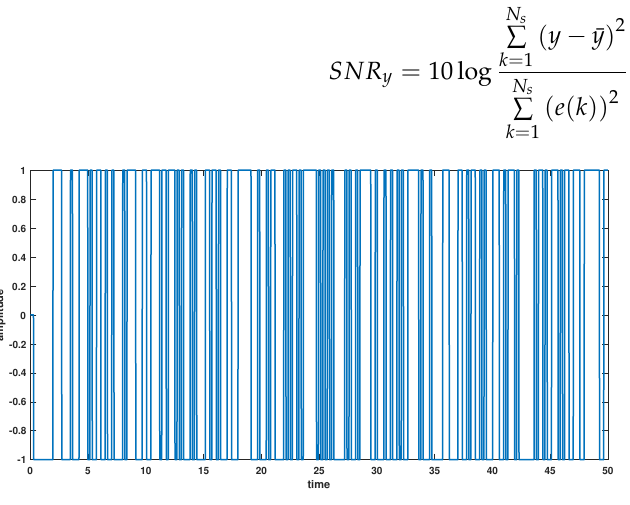
Figure 1. The excitation signal.